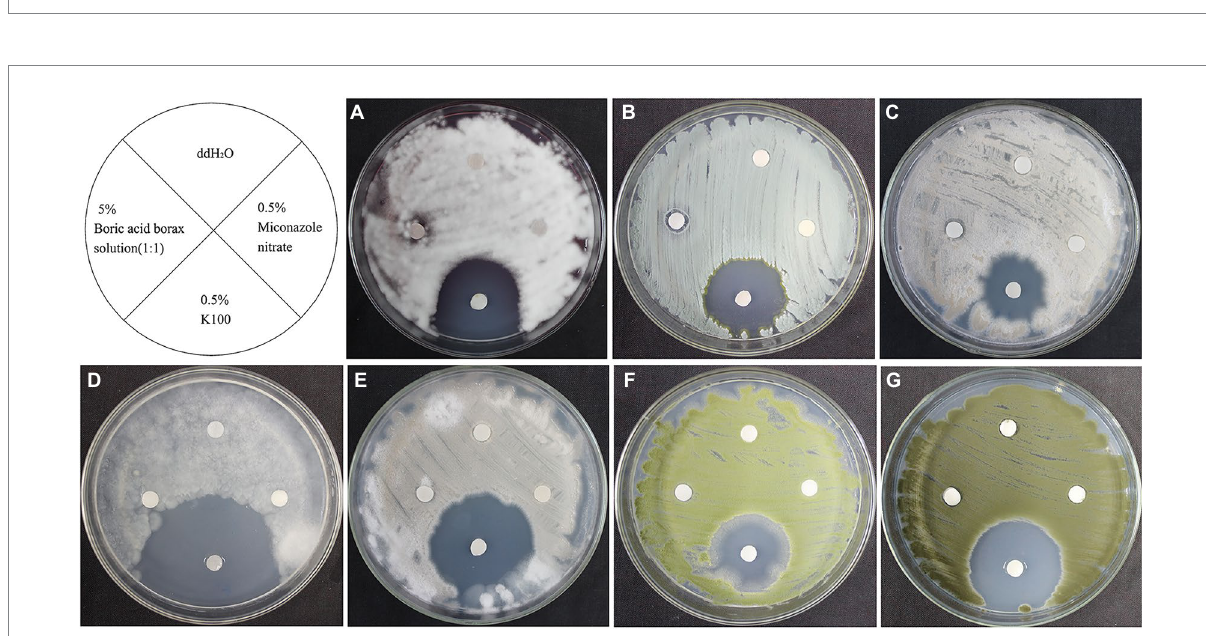
FIGURE 6 The fungistatic effects of 0.5% K100, 5% boric acid/borax solution (1:1), and 0.5% miconazole nitrate. The fungi were inoculated onto the PDA medium and incubated at 28 ° C for 3 days. (A) L. aphanocladii (NK-PF1). (B) P. aurantiogriseum (NK-PF2). (C) C. rosea (NK-PF3). (D) Mortierella sp. (NK-PF4). (E) M. alpina (NK-PF5). (F) A. flavus (NK-PF6). (G) C. halotolerans (NK-PF7).